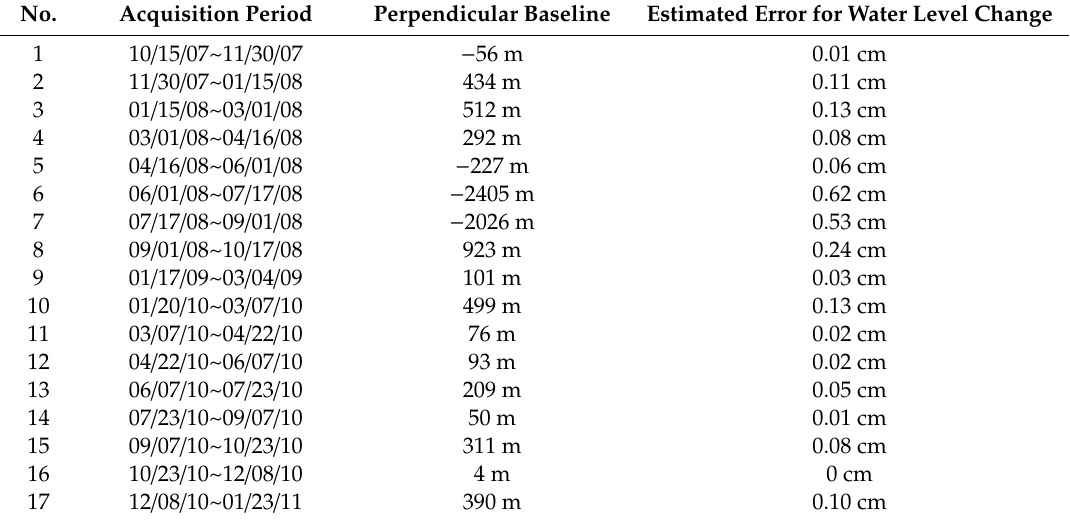
Table 3. InSAR pairs with